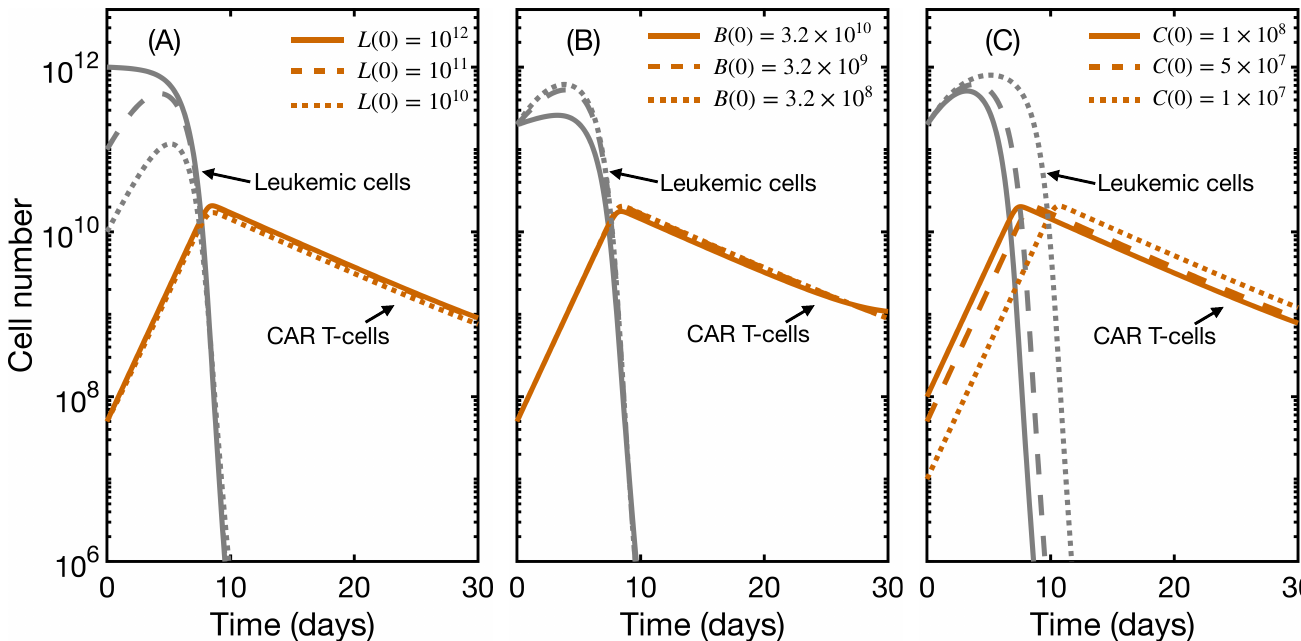
Figure 4. Influence of initial leukemia load, B-cell level, and CAR T dose on therapy outcome. Evolution with time of leukemic cells (gray) and total CAR T-cells (orange) for different initial configurations (In decreasing order: solid, dashed, dotted lines). When unchanged, initial values are B 0 ( 0 ) = 10 6 cells, B 1 ( 0 ) = 3 × 10 7 cells, B 2 ( 0 ) = 2 × 10 8 cells, B 3 ( 0 ) = 9 × 10 7 cells, L ( 0 ) = 2 × 10 11 cells, C A ( 0 ) = 5 × 10 7 cells and C M ( 0 ) = 0 cells. Parameters are those of Table 1 with α = 3 × 10 − 10 day − 1 · cell − 1 and h = 10 9 cells. ( A ) influence of leukemia burden; ( B ) influence of initial B-cell population, defined as the sum of all B-cell compartments; ( C ) influence of CAR T